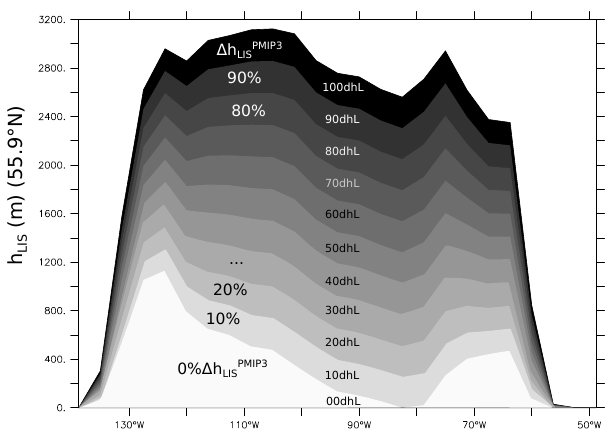
Figure 2. Laurentide ice-sheet height for each LMDZ experiment (with name of the corresponding experiment). The height of the LIS is defined as a relative difference between PMIP3 Laurentide ice- sheet height and the present-day topography ( (cid:49)h PMIP3 LIS